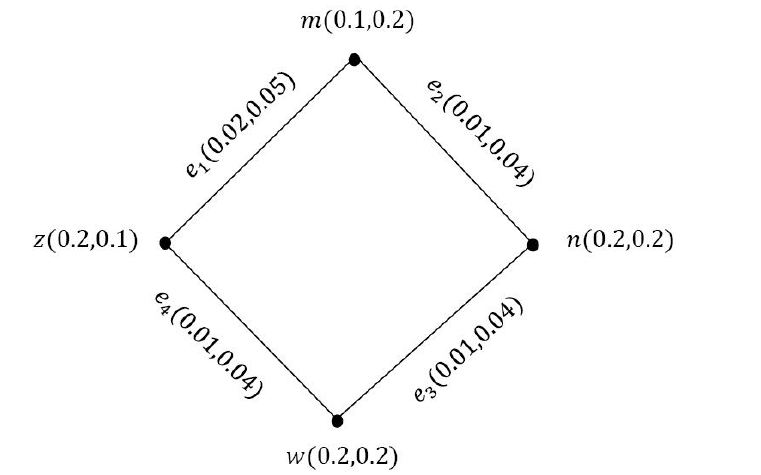
Figure 14. Product vague graph ζ with restrained independent